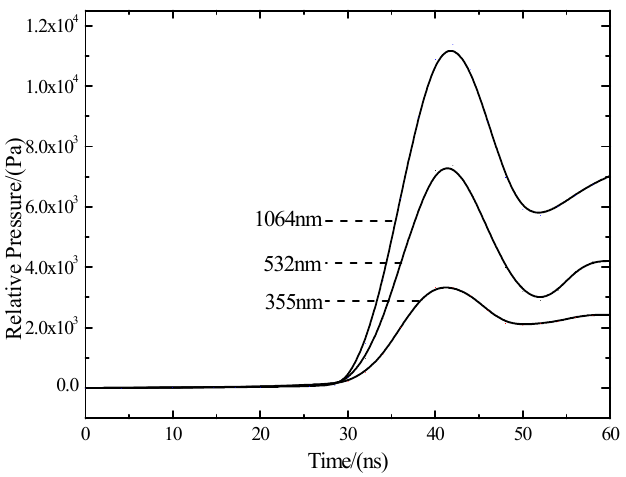
Figure 7. Three wavelengths of relative pressure curves.